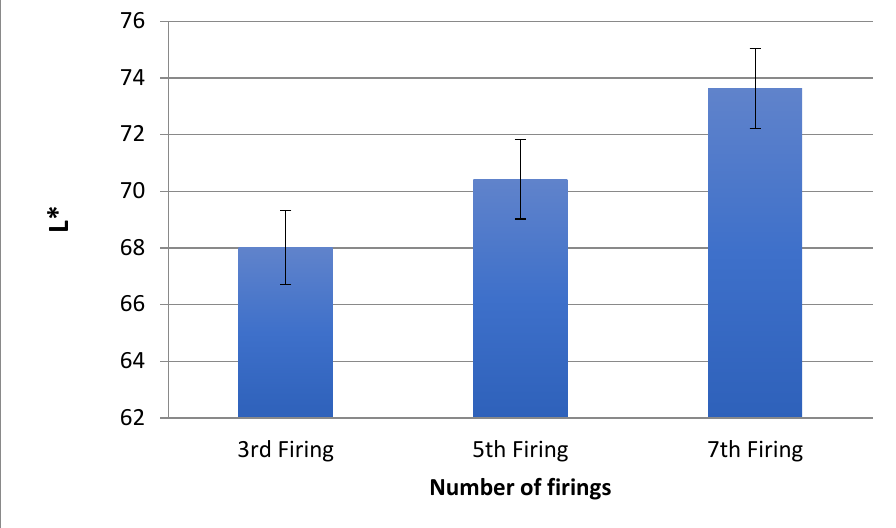
Figure 3. a* comparison of samples after the third, fifth, and seventh firings.